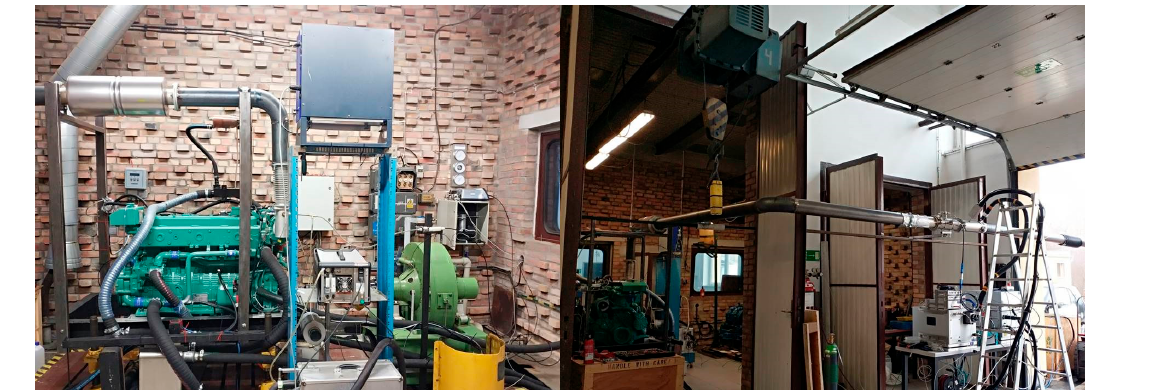
Figure 1. Diesel engine on the test stand in a laboratory at the Wroclaw University of Science and Technology.